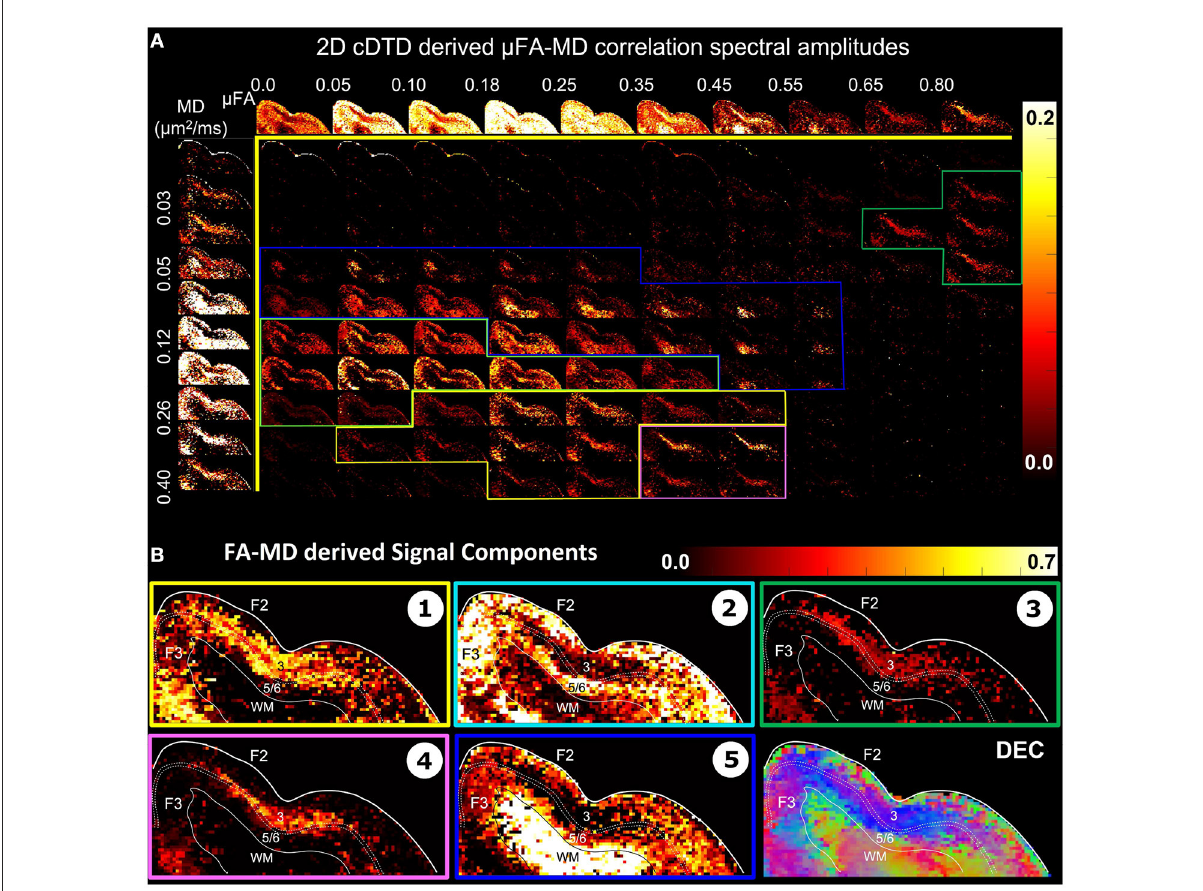
FIGURE7 MD correlation spectra in the section of the cortex from Figure 6. Top row: Spectral (A) Spectral amplitude maps of normalized 2D µ FA − component maps of the normalized 1D marginal distribution of microscopic fractional anisotropy, µ FA ; Left column: Spectral component maps of the normalized 1D marginal distribution of the microscopic diffusion tensor mean diffusivities. (B) Tissue component maps derived by MD distributions over empirically defined spectral regions reveal strong contrast in the mid-cortical integrating the 2D µ FA −